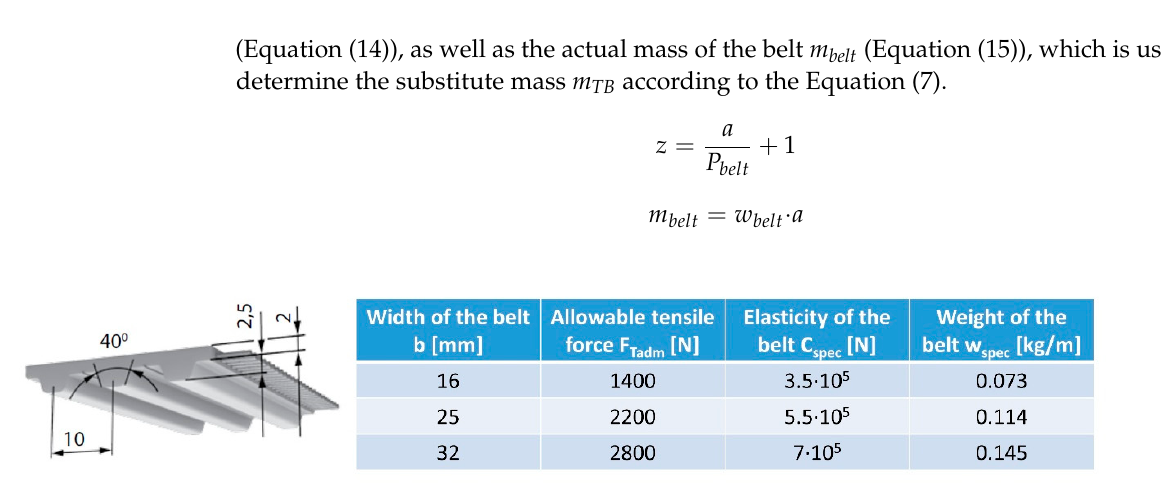
Figure 6. Belt catalog data including weight, and elasticity [28].